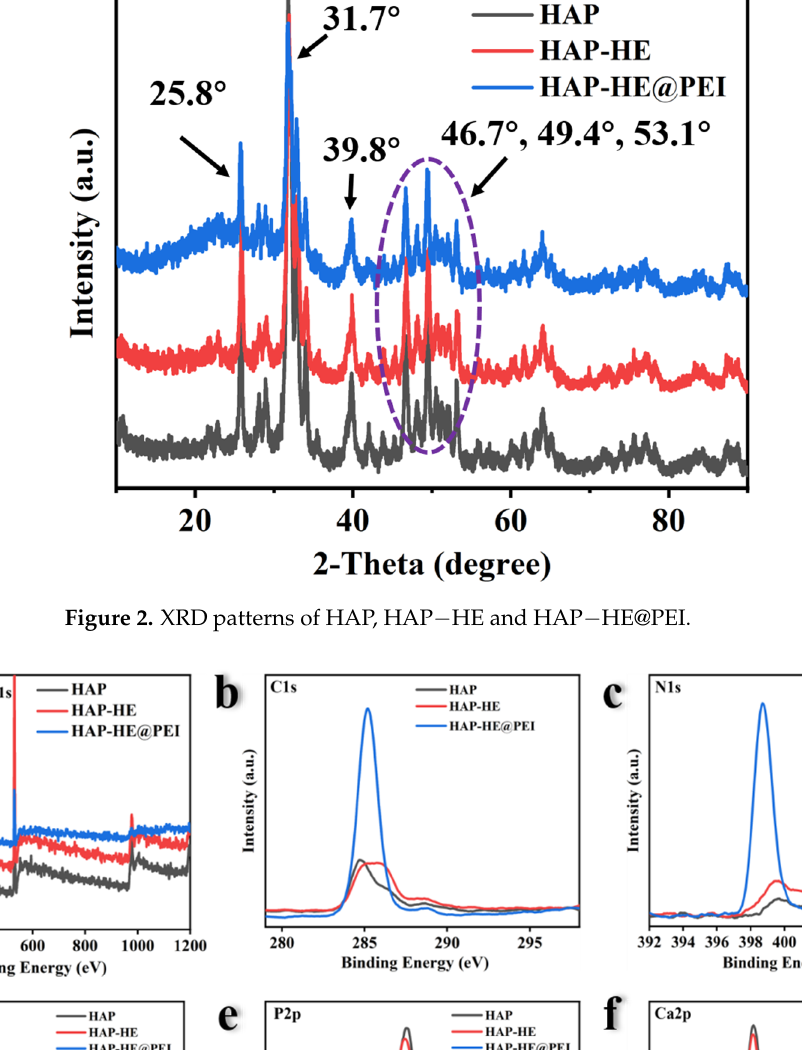
Figure 2. XRD patterns of HAP, HAP − HE and HAP − HE@PEI.